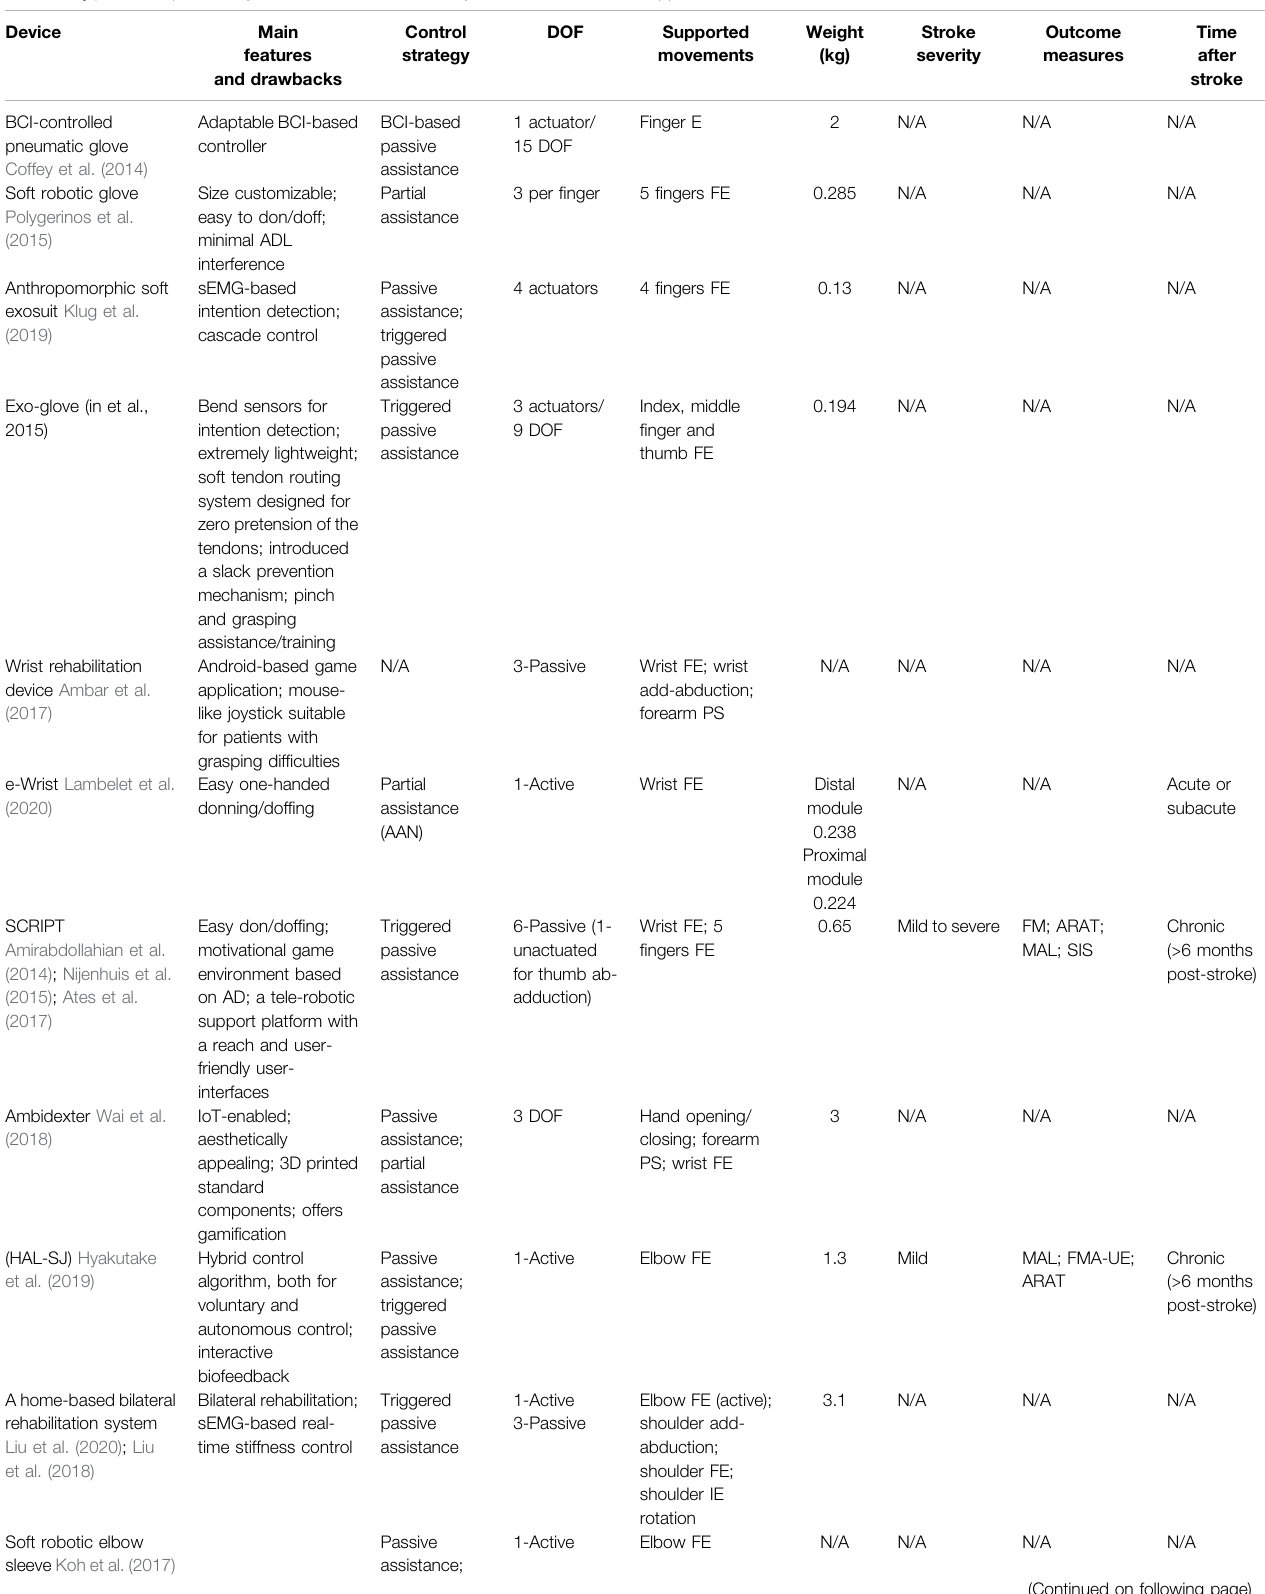
TABLE 1 | ( Continued ) Summary of state-of-the-art robotic systems for home-based upper-limb